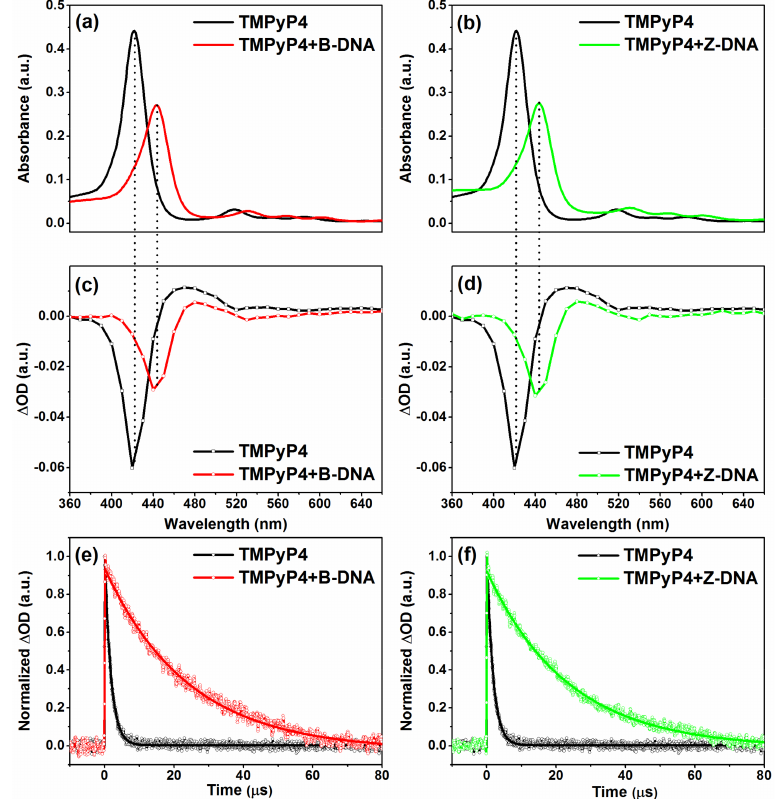
Figure 2. ( a , b ) Steady-state UV/Vis absorption spectra and ( c , d ) transient UV/Vis absorption spectra recorded instantly (50 ns) after laser flash photolysis upon 355 nm excitation for free TMPyP4 (2 µ M) and its complexes with each of the two DNA (50 µ M) in Na-cacodylate buffer (1 mM, pH = 7.0). Normalized triplet decay signals after laser flash photolysis of TMPyP4 (2 µ M) upon 355 nm excitation in the absence (black) and presence of B-DNA (50 µ M) ( e ) and Z-DNA (50 µ M) ( f ). Fitted curves are shown by solid lines. The fits are all obtained from complete decay